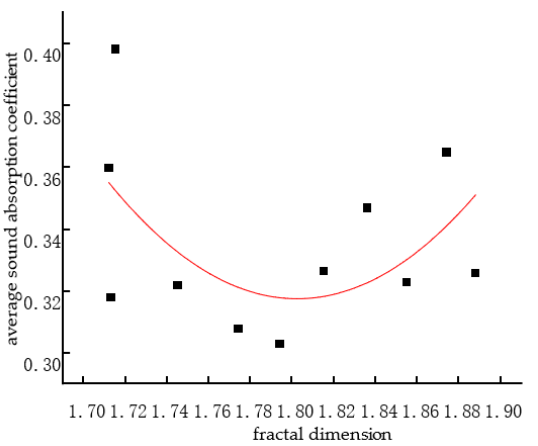
Figure 12. Fitting curve of average sound-absorption coefficient and fractal dimension.